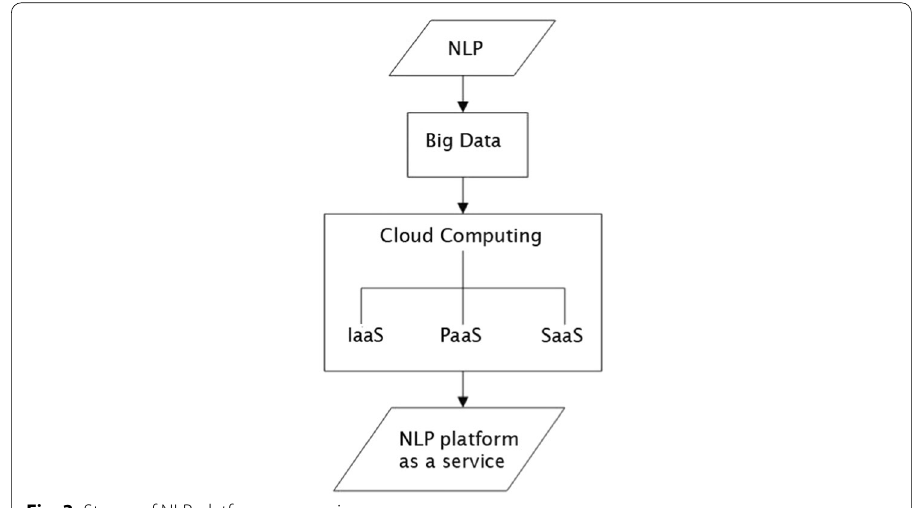
Fig. 3 Stages of NLP platform as a